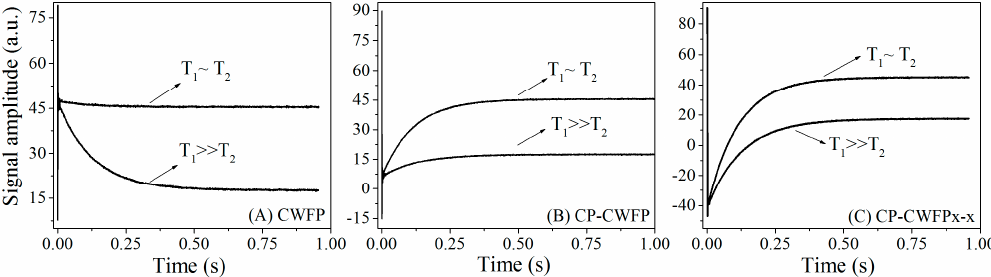
Figure 9. Experimental ( A ) CWFP, ( B ) CP-CWFP, and ( C ) CP-CWFPx-x signal for solution of CuSO 4 10 mM (T 1 = T 2 ) and MnSO 4 1 mM solution (T 1 >>T 2 ).